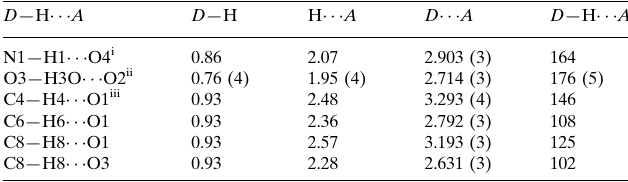
Hydrogen-bond geometry (A˚ , (cid:1)